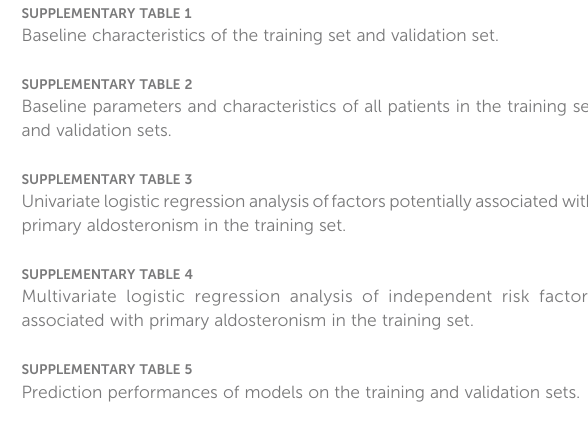
SUPPLEMENTARY FIGURE 2 The fl ow chars of patients screening in external validation cohort. SUPPLEMENTARY FIGURE 3 Weight coef fi cient of each predictor of the nomogram